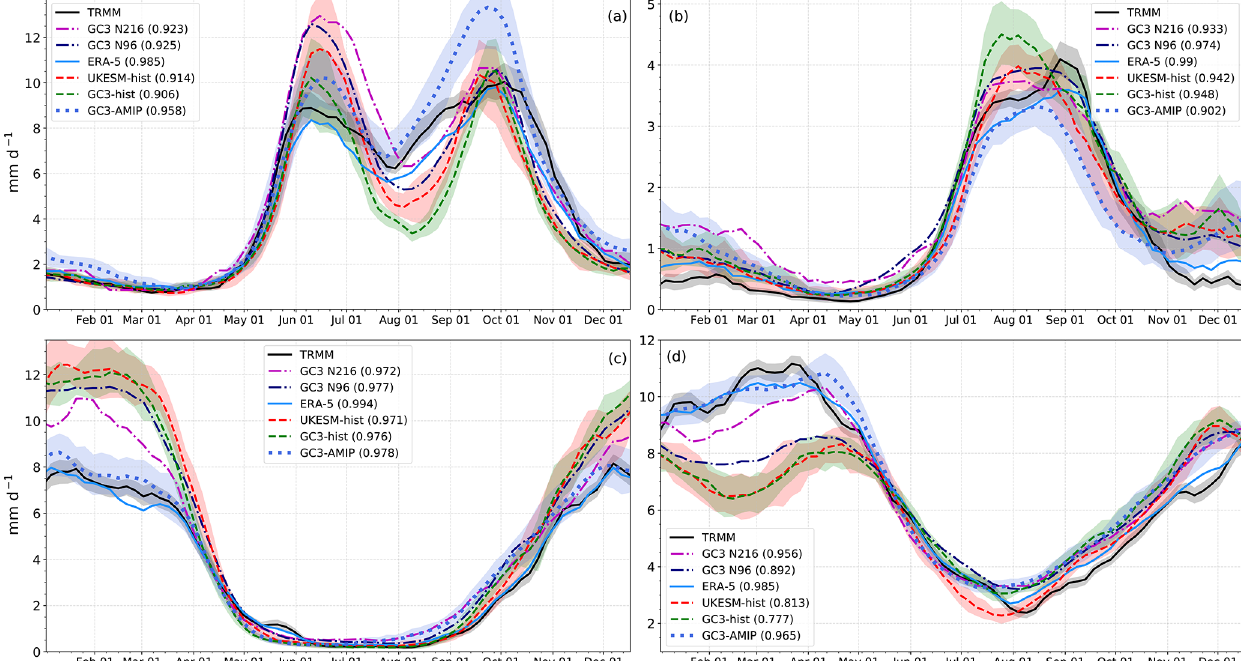
Figure 8. Annual cycle of pentad-mean rainfall in the regions (a) the midsummer drought, (b) the North American monsoon, (c) eastern Brazil and (d) the Amazon Basin. The regions are defined as in Fig. 3 and are illustrated in Figs. 7b and 8b. The shaded regions represent observational uncertainty for TRMM and ensemble spread for the historical experiments. The correlation coefficient for each of the simulated seasonal cycles with TRMM is given in brackets in each